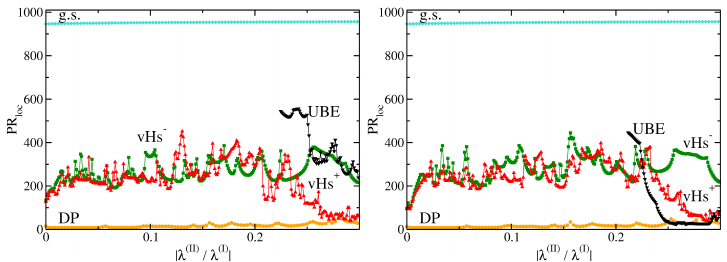
Figure 14. The same as in Figure 13 for the Africa-shaped hexagonal lattice with 1979 sites. Localization is considerably enhanced as compared to the hexagonal lattice with rectangular shape. The participation ratio PR loc ( E ) is reduced to about one quarter of that for the ground state for both cases. In stark contrast to the square lattice (cf. Figure 12), the noise surpasses the delocalizing effect of λ ( II , lII ) for values of | λ ( II ) / λ ( I ) | (cid:46) 0.016 and localization is enhanced with respect to the noiseless case up to slightly above that value. The localization of the wave functions with minimal PR loc ( E ) at the vHs + and at the upper band edge (UBE) is considerably enhanced when introducing